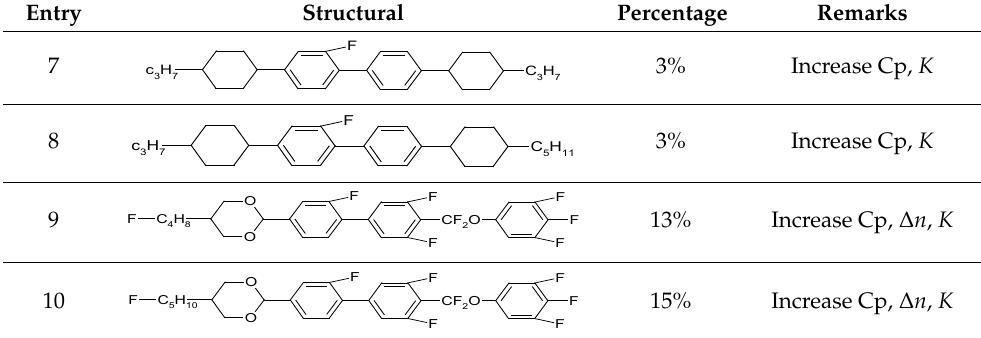
Table 5. Physical Parameters.